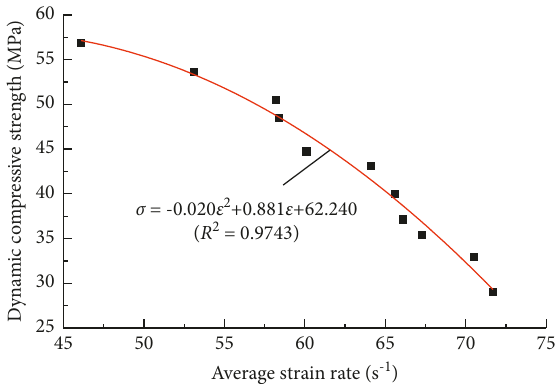
Figure 6: Fitting curve of dynamic compressive strength and average strain rate.